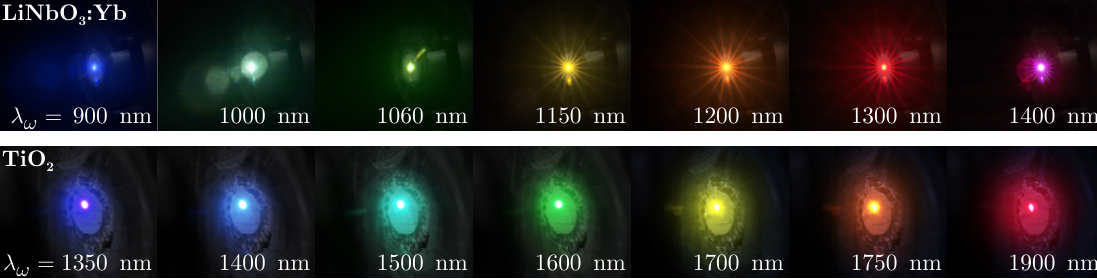
Figure 4. Harmonic emission of LiNbO 3 :Yb- ( top ) and TiO 2 -nanopowder ( bottom ) at different fundamental wavelengths in the range λ ω = ( 900–1900 ) nm photographed with a digital